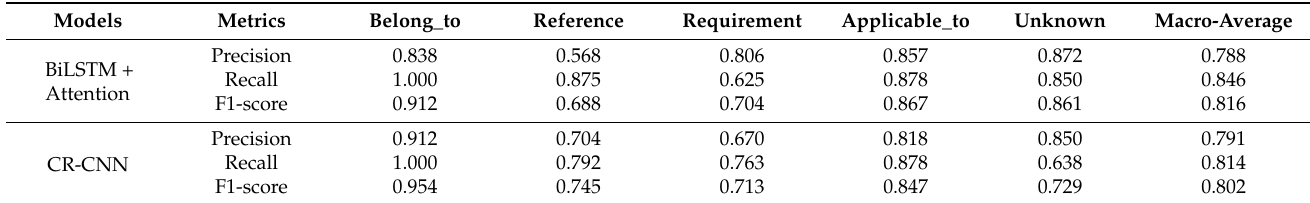
Table 3. Relationship extraction model results metrics.